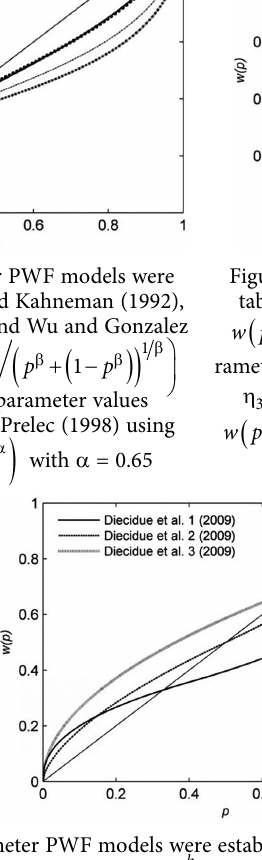
Figure 4. Three-Parameter PWF models were established by Diecidue et al. (2009) by using ( ) a w p cp = for ˆ p p ≤ and − . The parameters a , b and ˆ p are 0.42, 0.35 and 0.40; 0.62, 0.62 and 0.50; 0.50, 0.60 and 0.60,